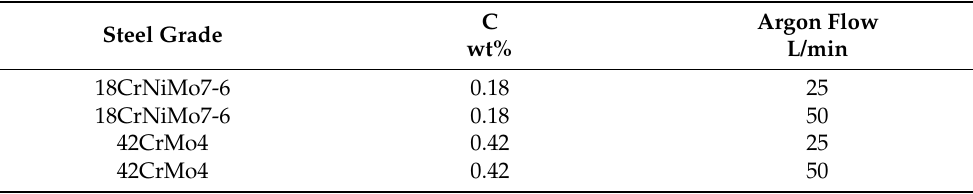
Table 6. Considered parameters of liquid steel during refining in a ladle in the conducted numeri- cal